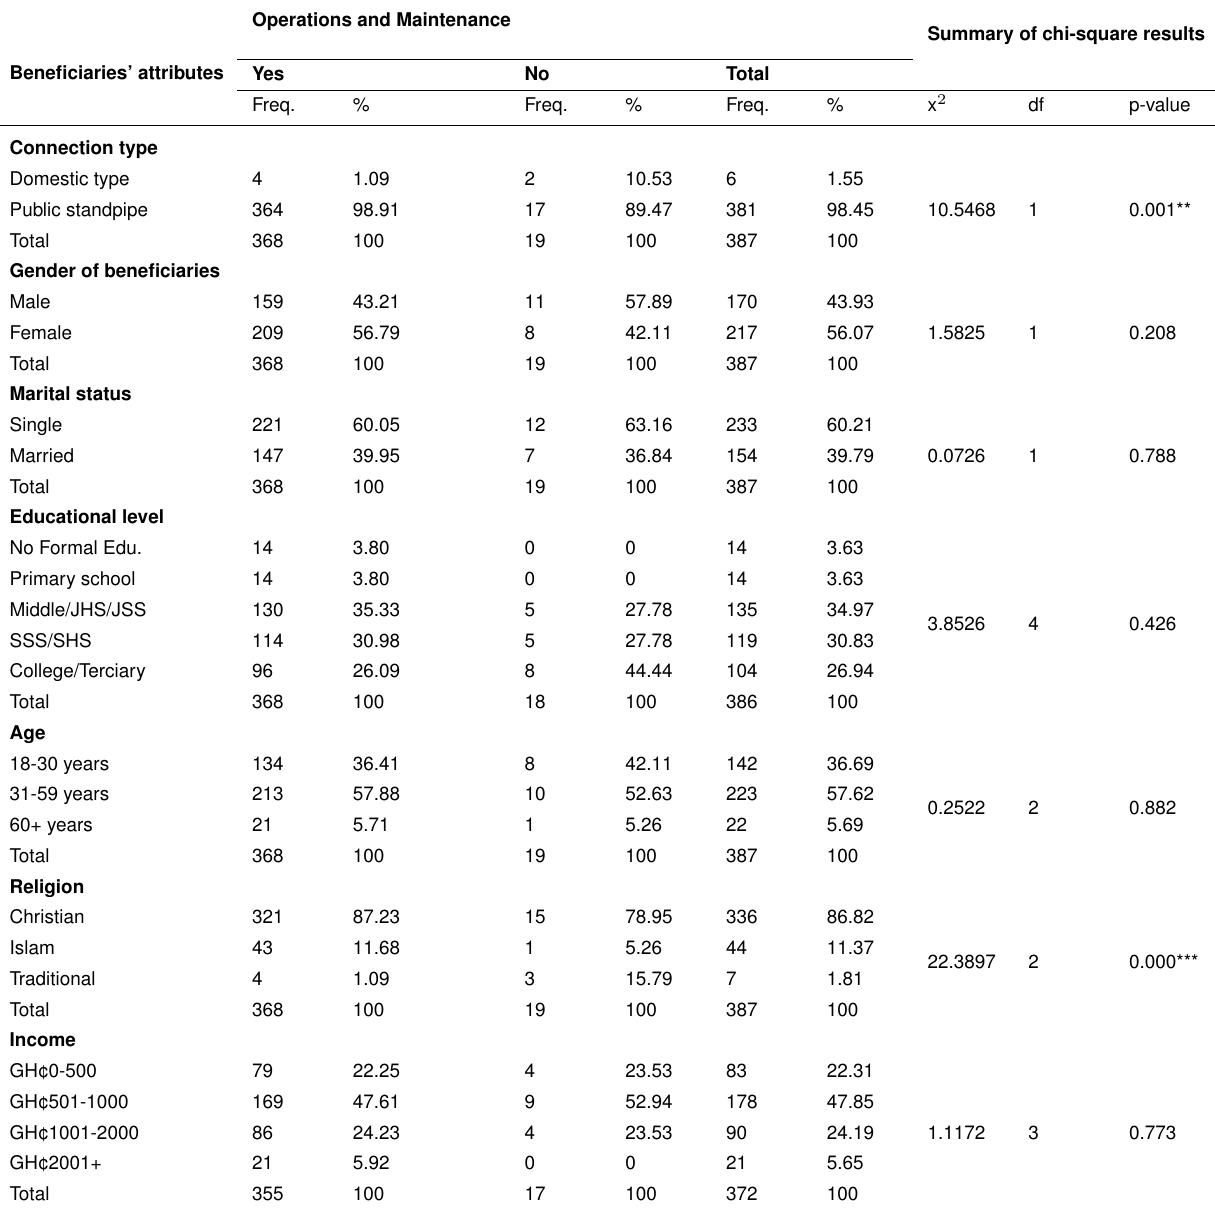
Table 2. Cross-tabulation of beneficiaries’ attributes and perception of